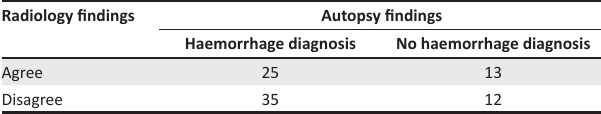
TABLE 2: Summary of diagnostic category for intracranial haemorrhage, South Africa, 2014–2016.